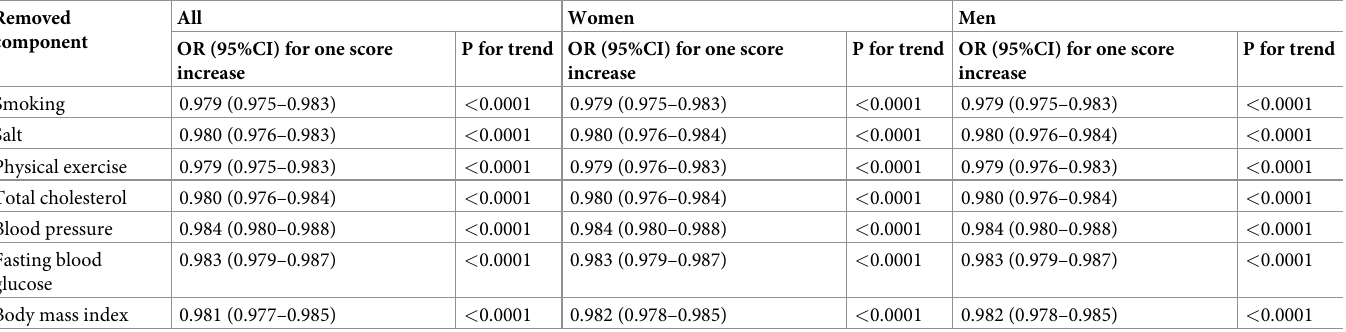
Table 4. Odds ratios (ORs) and 95% confident intervals (95%CI) of CKD according to the cumulative exposure of CVH from 2006 to 2010, after one individual car- diovascular health is removed from the total score. Removed All Women Men component OR (95%CI) for one score P for trend OR (95%CI) for one score P for trend OR (95%CI) for one score P for increase increase increase